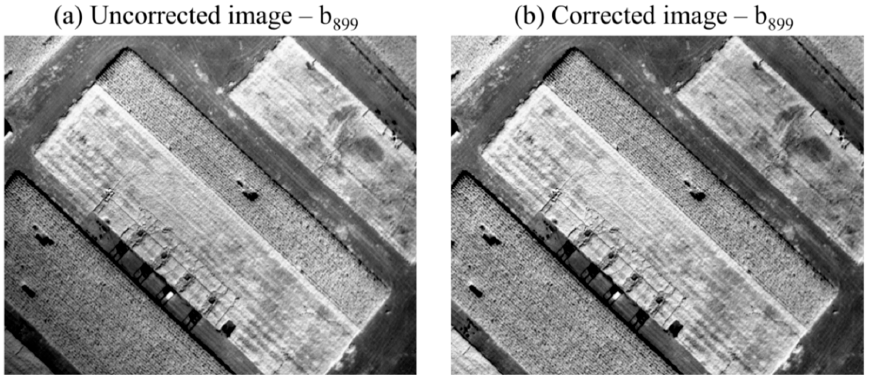
Figure 8. ( a ) Example for an uncorrected image (RAW format) recorded in b 831 ; and ( b ) the respective image after noise reduction and consecutive vignetting correction.